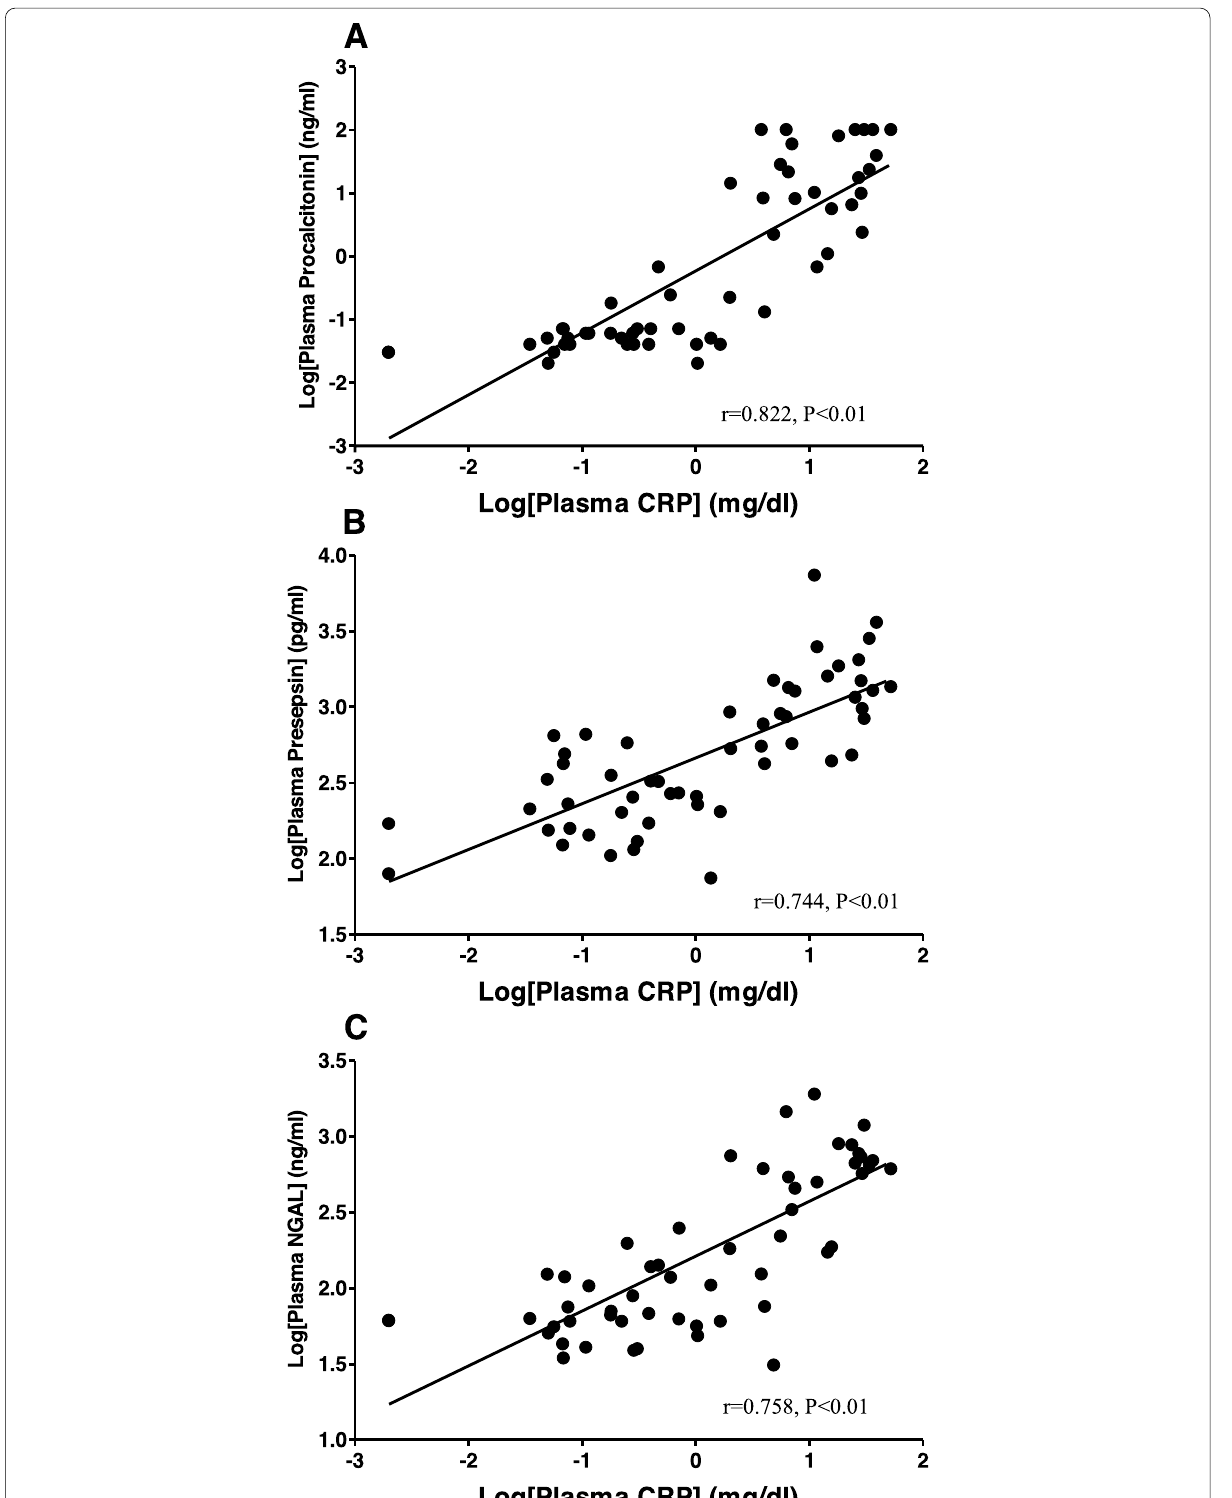
Fig. 2 There was significant correlation between CRP and other plasma inflammatory biomarkers. A Procalcitonin. B Presepsin. C NGAL (neutrophil gelatinase-associated